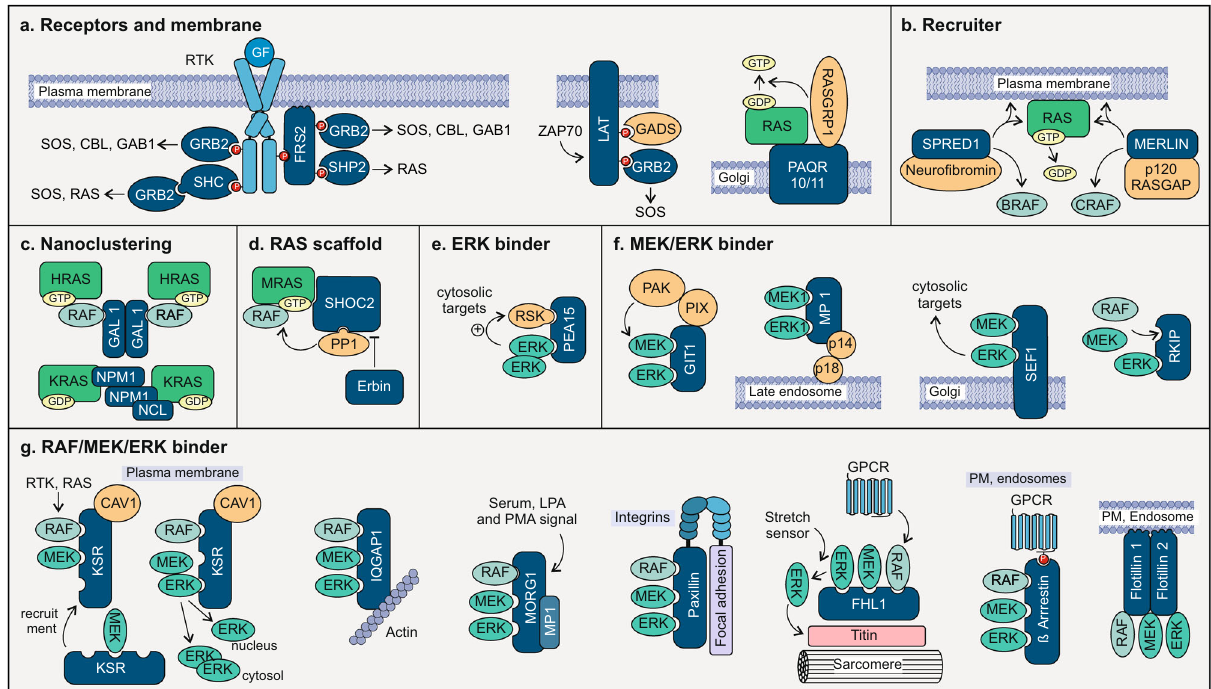
Fig. 2 Involvement of RTK-RAS-MAPK accessory proteins in signal transduction. Accessory proteins are involved in every step of the RTK-RAS-MAPK pathway and increase the connectivity between signalling components. Adaptor proteins and docking proteins interact with phosphorylated receptors, in contrast to anchoring proteins, which are directly associated with the membrane ( a ). Recruiter translocate binding partner towards the site of action, e.g., a GTPase activating protein to activated RAS at the plasma membrane ( b ). Scaffold proteins that induce nanoclustering, increase the local concentration of their binding partner in lipid rafts ( c ). RAS scaffold proteins bind RAS and other components of the RTK-RAS-MAPK pathway ( d ), whereas ERK binder ( e ), MEK/ERK binder ( f ) and RAF/MEK/ERK binder ( g ) can connect one, two, or all three members of the MAPKs, bringing them close together, regulate their activity and determine their localisation. See text for more